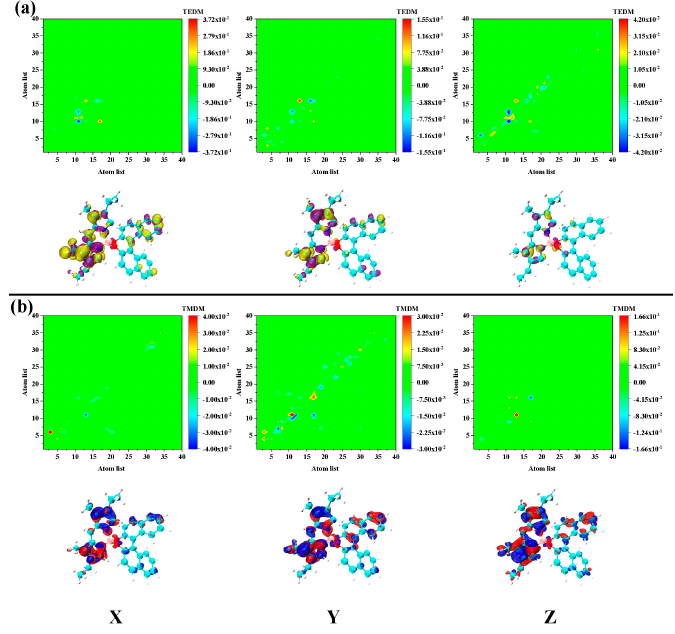
Figure 6. The transition ( a ) electric / magnetic ( b ) dipole moment matrix (upper) and density (under) isosurface of S 3 in PM567. The yellow and purple isosurfaces represent the positive and negative transition electric dipole moments, respectively, and the red and blue isosurfaces denote the positive and negative transition magnetic dipole moments, respectively. Catalysts 2020 , 10 , x FOR PEER REVIEW